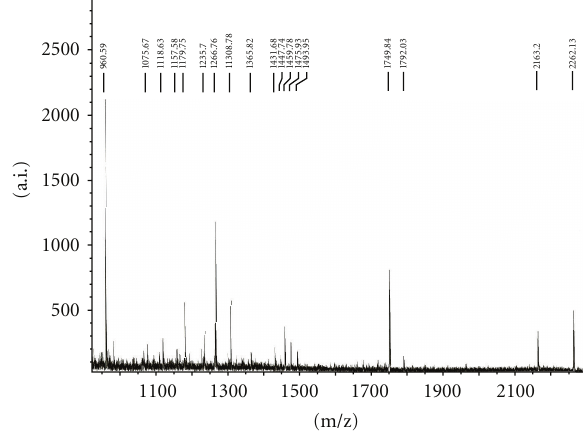
Figure 10: Peptide mass fingerprinting map of protein spot 5.